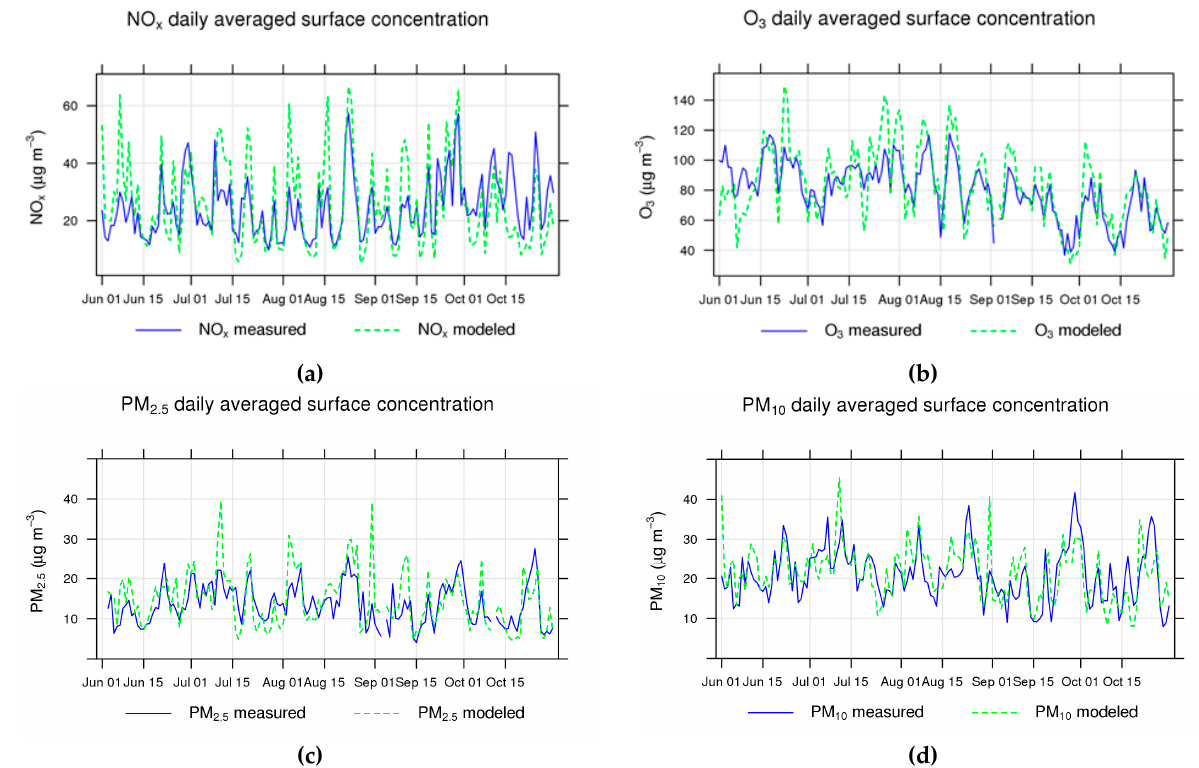
Figure 5. Time series of BOLCHEM modelled (green dotted line) and observed (blue solid line) daily averaged concentrations ( µ g m − 3 ) of ( a ) NO X , ( b ) O 3 , ( c ) PM 2.5 , and ( d ) PM 10 , averaged over ARPA-Puglia and ASI monitoring stations. Table 5. BOLCHEM modelled and measured concentrations ( µ g m − 3 ) averaged over ARPA-Puglia and ASI monitoring stations and over the whole period June–October